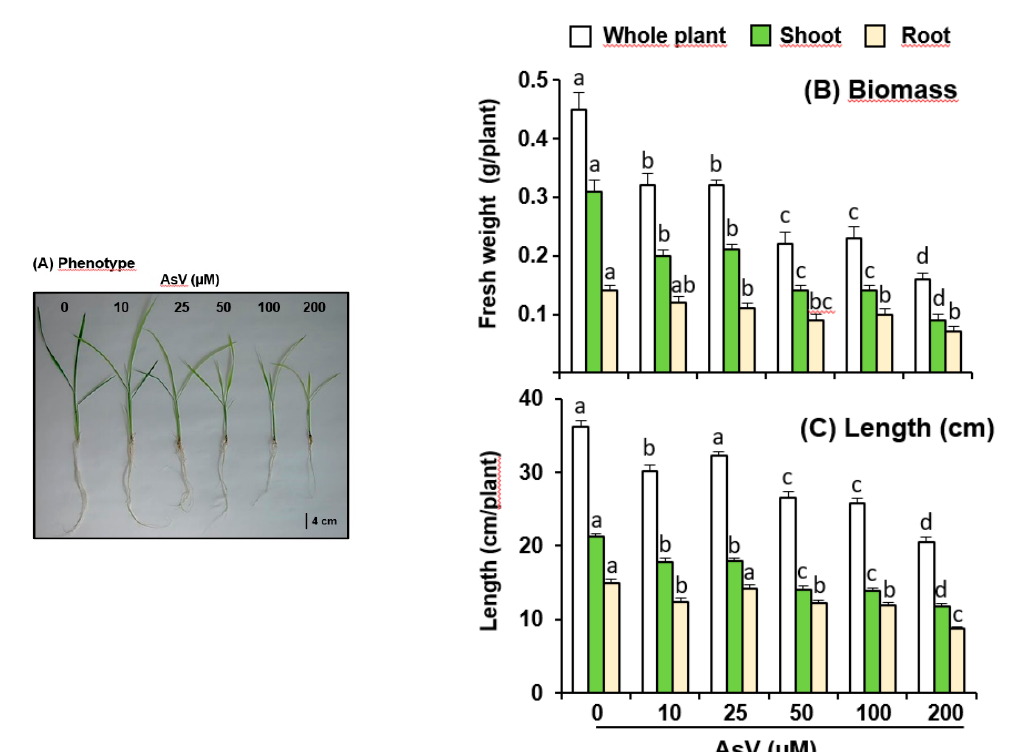
Figure 2. E ff ect of arsenate (AsV) on 26-d-old rice seedlings grown in hydroponic solutions supplemented the last 12 days with di ff erent AsV concentrations. ( A ) Representative image of Figure 2. Effect of arsenate (AsV) on 26-d-old rice seedlings grown in hydroponic solutions rice seedlings at all As concentrations used in this work. ( B ) Plant biomass (g / plant). ( C ) Plant length supplemented the last 12 days with different AsV concentrations. ( A ) Representative image of rice (cm / plant). Data are means ± SEM of at least three independent experiments. One-way Anova was seedlings at all As concentrations used in this work. ( B ) Plant biomass (g/plant). ( C ) Plant length used for comparisons between means using the program Statgraphics Centurion. Di ff erent letters over (cm/plant). Data are means ± SEM of at least three independent experiments. Different letters over the the columns for each organ (either whole plant, shoot or root) indicate that di ff erences with respect to columns for each organ (either whole plant, shoot or root) indicate that differences with respect to control (0 µ M AsV) values were statistically significant at p < control (0 μ M AsV) values were statistically significant at p < 0.05.